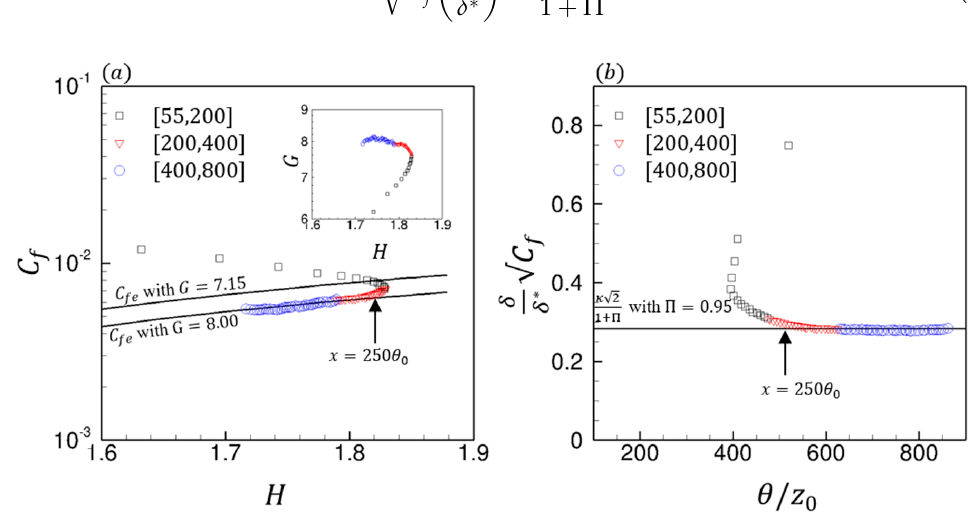
Figure 11 . ( a ) Streamwise variation of 𝐶 (cid:3033) = 2(𝑢 (cid:3099) /𝑈 (cid:2998) ) (cid:2870) as a function of the shape factor 𝐻 for case Figure 11. ( a ) Streamwise variation of C f = 2 ( u τ / U ∞ ) 2 as a function of the shape factor H for (cid:16) (cid:17) 2 (cid:3009)(cid:2879)(cid:2869) ) (cid:2870) with listed values of 𝐺 . The profile of 𝐺 in- R. Solid black lines in ( a ) represent 𝐶 (cid:3033)(cid:3032) = 2( H − 1 case R. Solid black lines in ( a ) represent C fe = 2 with listed values of G . The profile (cid:3009)(cid:3008) HG of G included in the inset of ( a ) is calculated using the DNS predictions of C f and H for case cluded in the inset of ( a ) is calculated using the DNS predictions of 𝐶 (cid:3033) and 𝐻 for case R. ( b ) Evo- (cid:113) (cid:3083) C f along θ / z 0 for case R. Solid black line in ( b ) presents the relation R. ( b ) Evolution of δ / δ ∗ lution of 𝛿/𝛿 ∗ (cid:3493) 𝐶 (cid:3033) along 𝜃/𝑧 (cid:2868) for case R. Solid black line in ( b ) presents the relation (cid:3493) 𝐶 (cid:3033) = (cid:3083) ∗ √ (cid:113) δ 𝜅√2/(1 + Π) with Π = 0.95 . In both ( a , b ), black squares: 55 < 𝑥/𝜃 < 200 (section (𝑖)) ; red trian- C f = κ 2/ ( 1 + Π ) with Π = 0.95. In both ( a , b ), black squares: 55 < x / θ 0 < 200 (section ( i )) ; (cid:2868) δ ∗ gles: 200 < 𝑥/𝜃 (cid:2868) < 400 (section ( ii )); blue circles: 400 < 𝑥/𝜃 (cid:2868) < 800 (section ( iii )). red triangles: 200 < x / θ 0 < 400 (section ( ii )); blue circles: 400 < x / θ 0 < 800 (section ( iii